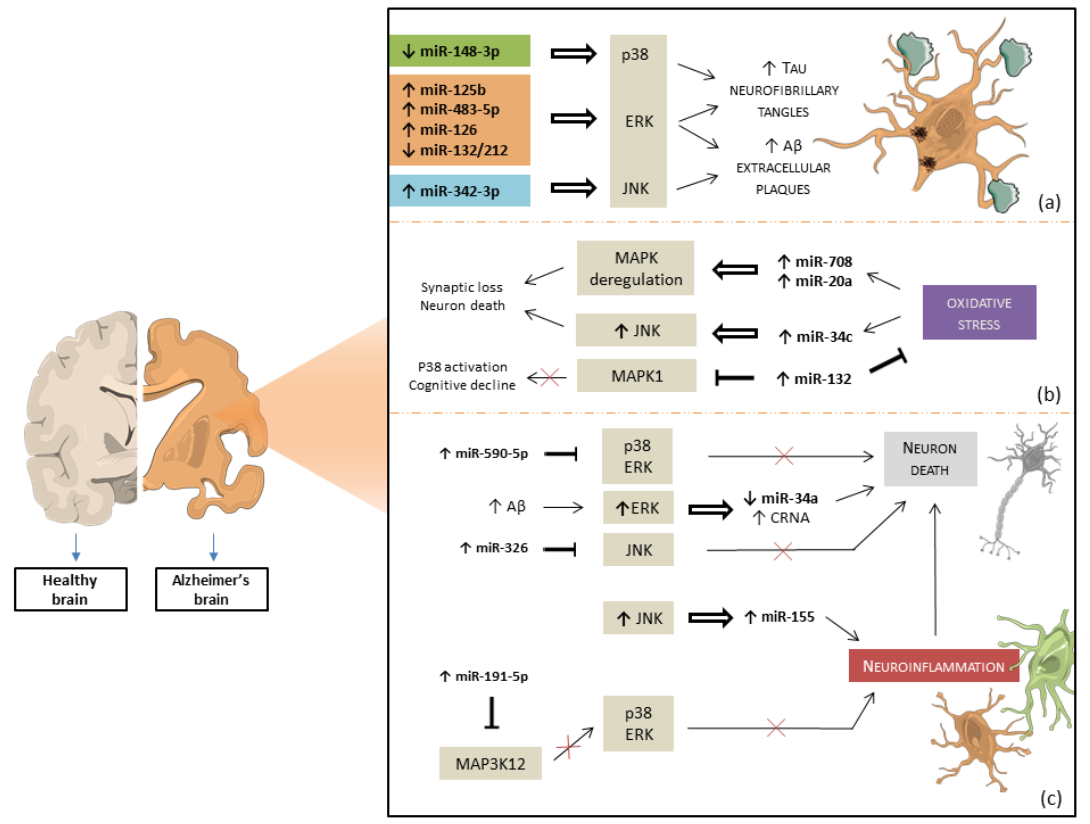
Figure 3. miRNAs and MAPKs interaction in Alzheimer’s disease. ( a ) The overexpression or downregulation of miRNAs can act on p38 MAPK, JNK, and ERK in a direct or indirect way, exacerbating NFT and amyloid extracellular plaques in AD neurons. ( b ) Oxidative stress enhances miRNAs expression during AD, causing deregulation in the MAPK pathway and, consequently, synaptic and neuron loss. The overexpression of miR-132 decreases oxidative stress, p38 MAPK, and cognitive decline by targeting MAPK1. ( c ) The Aβ depositions induce ERK activation, which leads to a decrease in miR-34a expression levels and, thus, to neuronal death due to the CRNA. The overexpression of miR-590-5p and miR-326 plays an anti-apoptotic effect through indirect inhibition of p38 MAPK, ERK, and JNK activation. JNK mediates downstream miR-155 upregulation and promotes neuroinflammation during AD. The overexpression of miR-191-5p reduces microglia injury through the decrease in p38 MAPK and ERK activity by targeting the upstream MAP3K13 effector. Neuroinflammation plays an important role in the onset and progression of neurodegeneration and neu-